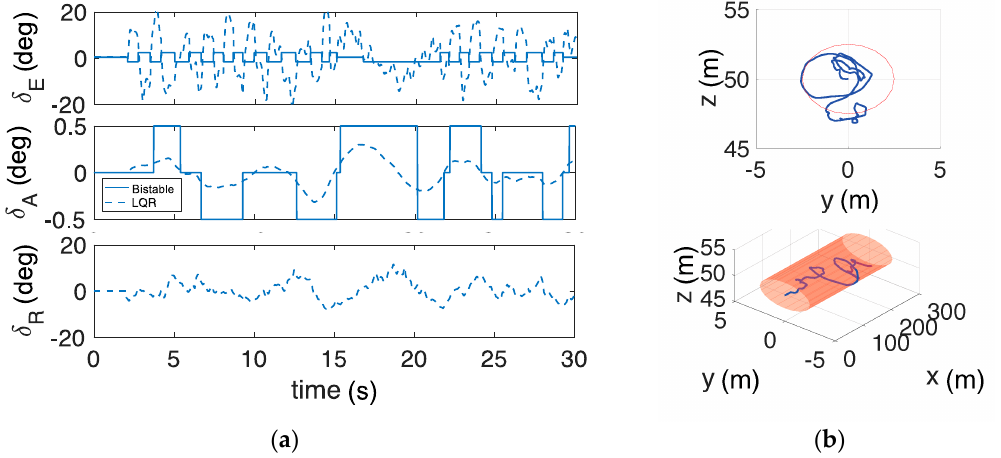
Figure 12. UAV gust response: ( a ) elevator, ailerons and rudder deflections (continuous and discrete behavior) and ( b ) UAV 3D trajectory with discrete command surfaces.